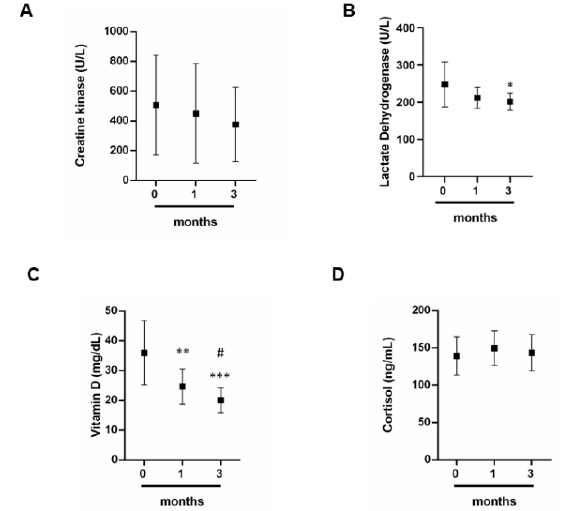
Figure 3. Biochemical parameters. ( A ) Creatine kinase, ( B ) LDH, ( C ) vitamin D and ( D ) cortisol dosage